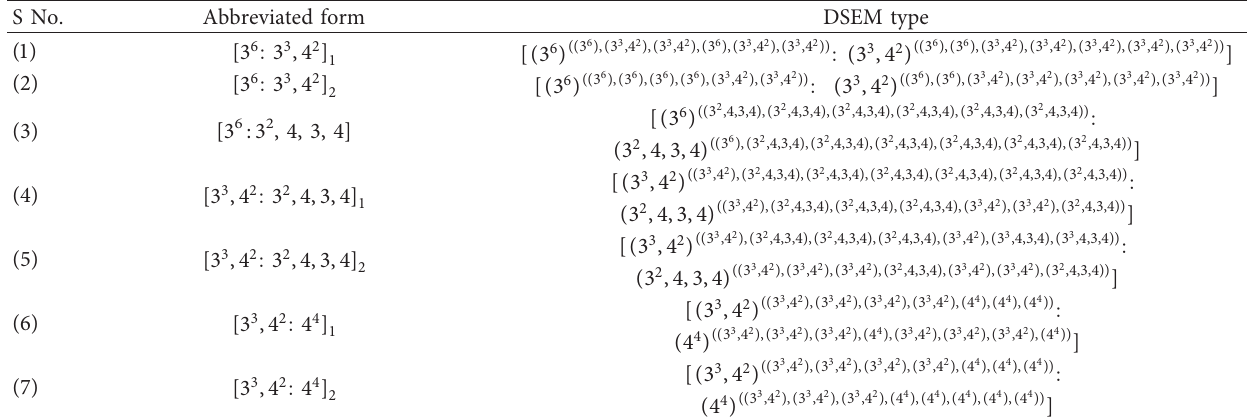
, [ 3 6 : 3 3 , 4 2 ] , [ 3 6 : 3 2 , 4 , 3 , 4 ] , [ 3 3 , 4 2 : 4 4 ] 1 2 Table 2: Tabulated list of DSEMs of face-size 4.